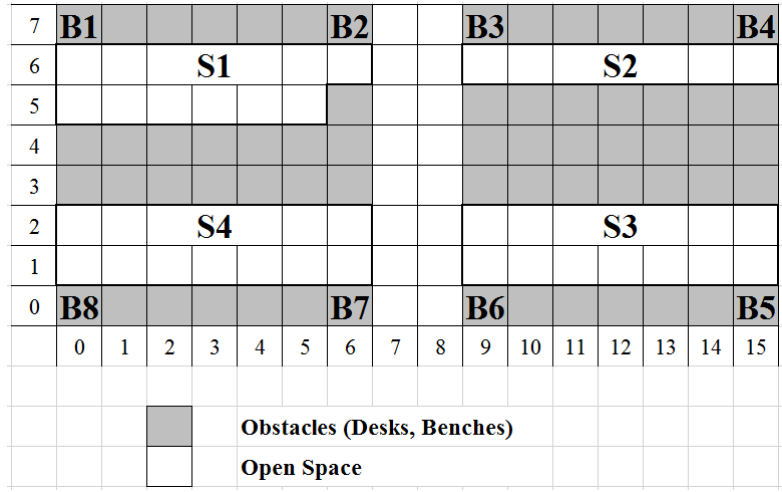
Figure 5. Beacon